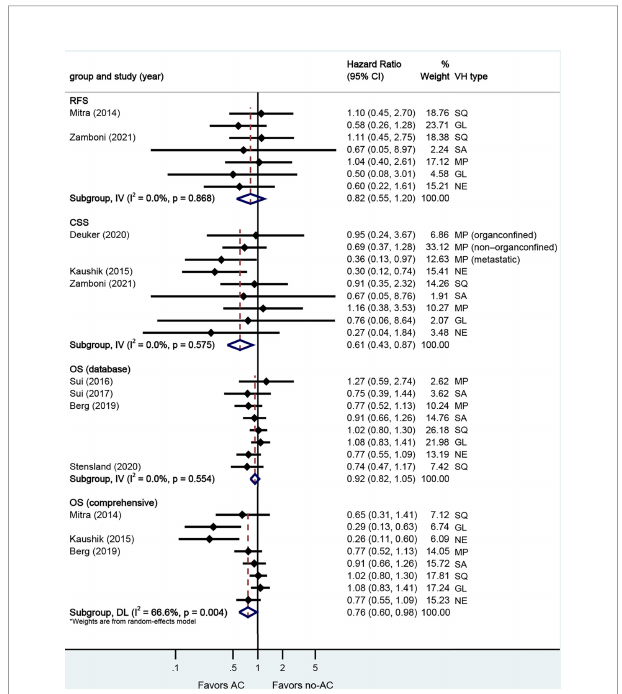
FIGURE 3 | Forest plots of studies investigating the association of adjuvant chemotherapy with survival outcomes in variant histology. MP, micropapillary; SQ, squamous; GL, glandular; NE, neuroendocrine; SA, sarcomatoid; NR, not